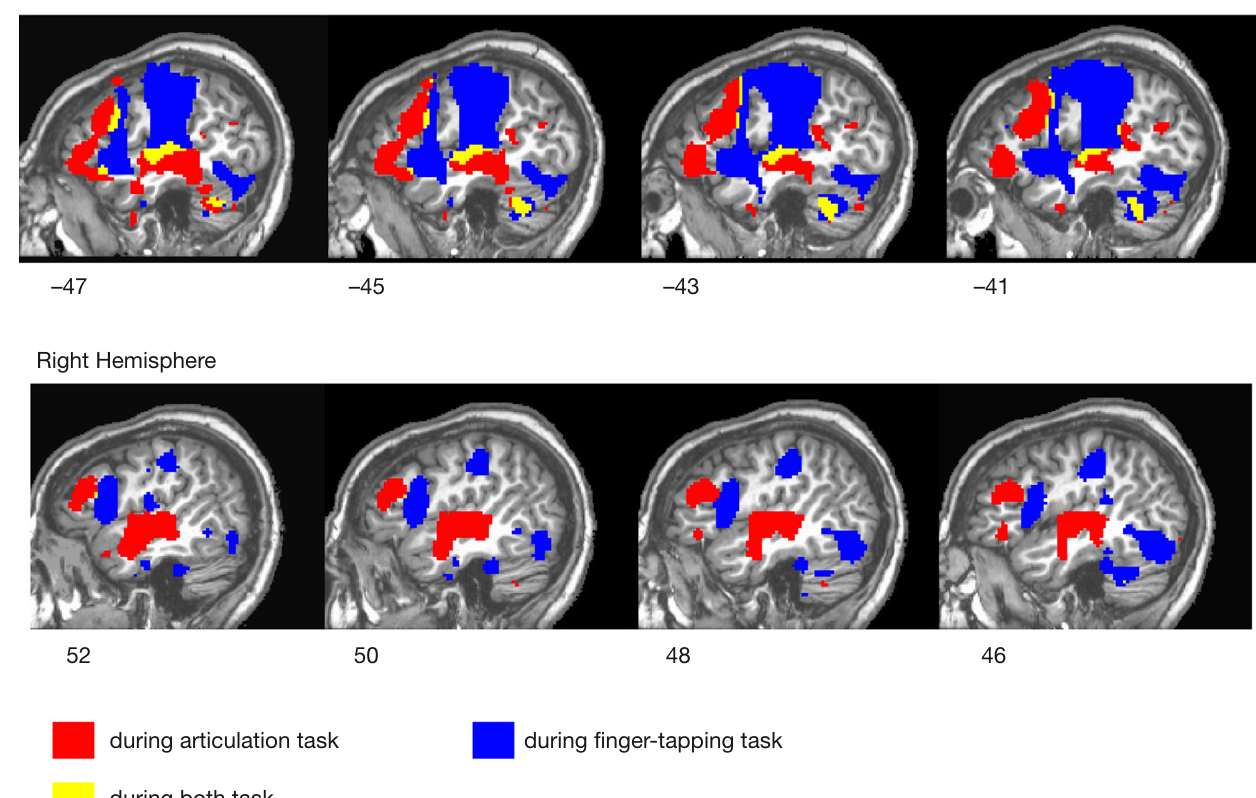
Figure 4 | Regions active across subjects during the performance of both tasks and each task, respectively, in the absence of sentence presentation, compared to rest ( p <